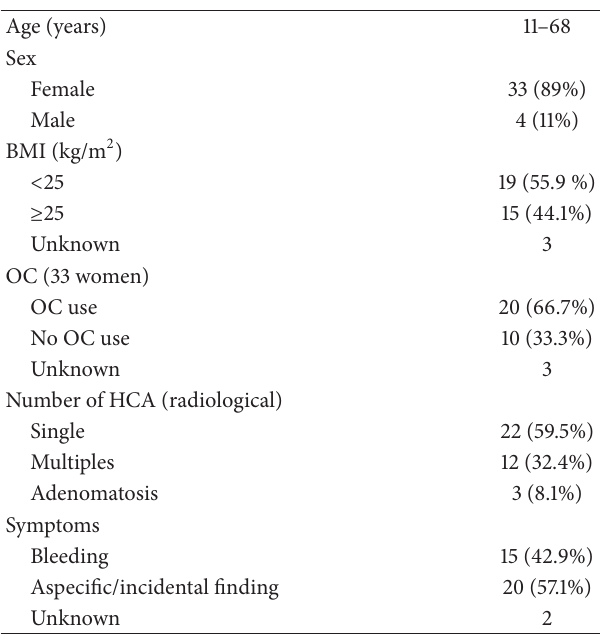
Table 1: Clinical